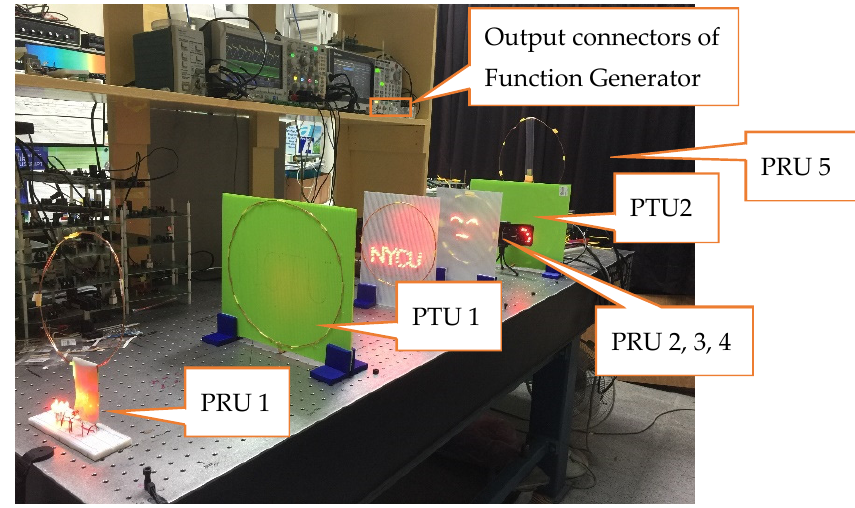
Figure 22. Integration of the VFPWM of the cCCDA scheme applied to WPT.